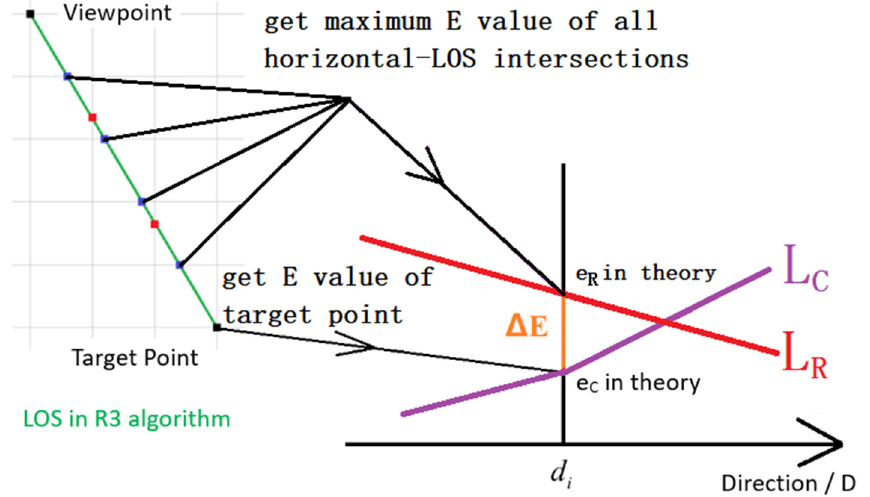
Figure 6. The principle of the checking algorithm for PDERL based on the line-of-sight, where horizontal-LOS intersections refer to the intersections of the LOS and the horizontal grid line.